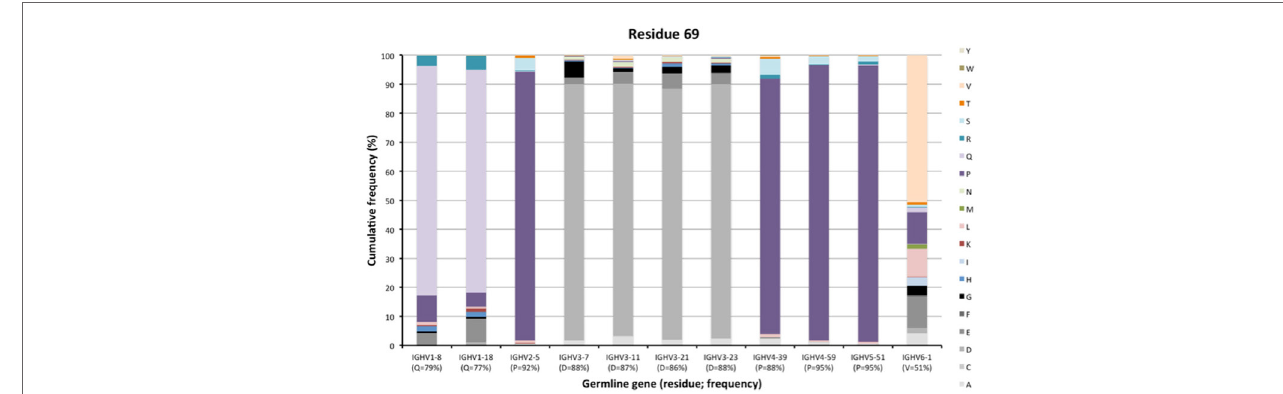
FigUre 5 | Extent of diversification of residues close to complementarity determining region (CDR) in the linear protein sequence as encoded by transcripts of different germline gene origins. Residues shown include residues 39, 40, 42 immediately after CDRH1, and residues 54–55 immediately before and residues 66–69 immediately after CDRH2 of IgG. Residue 41, a conserved tryptophane belonging to the domain’s core, is not diversified in products encoded by any germline gene. The germline-encoded residues and their frequencies in IgG-encoding transcripts are shown at the bottom of the